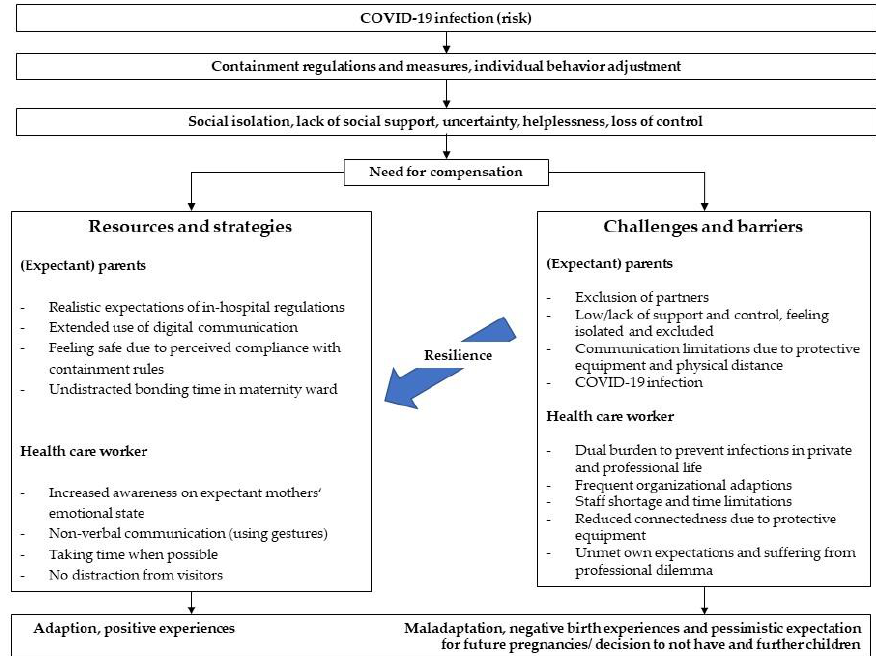
Figure 1. Overview on perceived barriers and